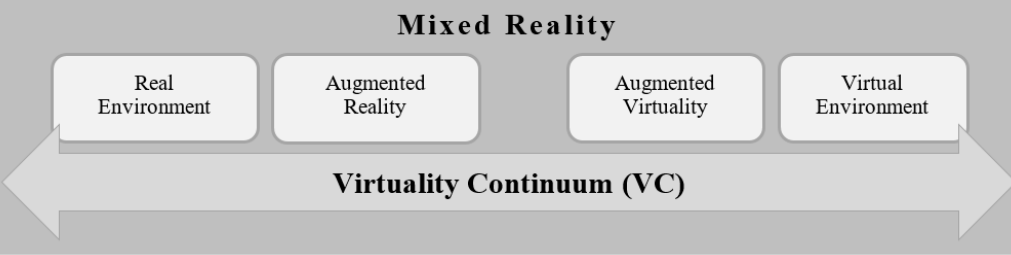
Figure 10: Presentation of paper